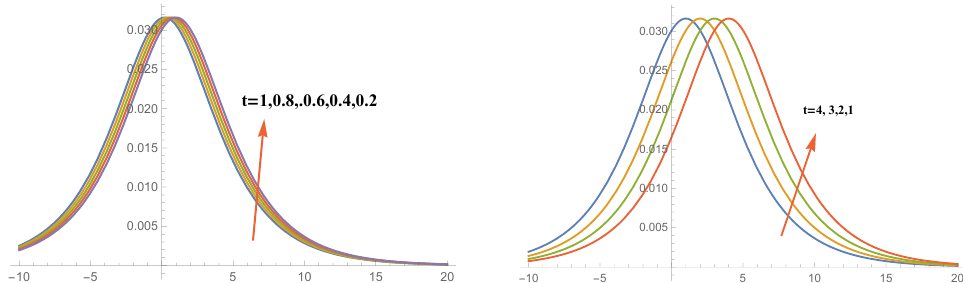
Figure 1. The soliton solution by Sinc-collocation method for different values of time t , and − 10 ≤ x ≤ 20.